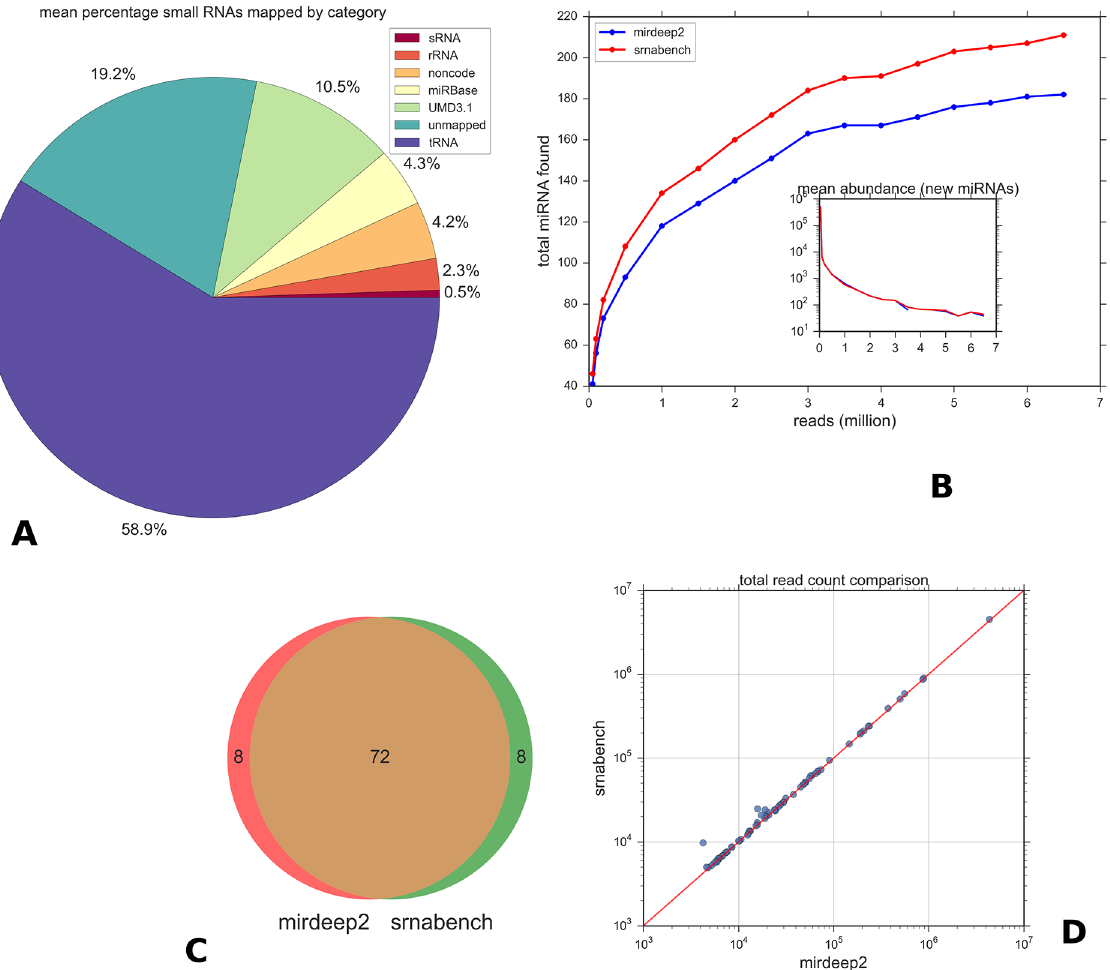
Fig 2. miRNA abundances in miRDeep2 and sRNAbench. A: Proportion of reads mapped to different small RNAs. Values are the average percentage over all samples. Reads matching tRNA dominate. The unmapped percentage is likely due to mismatches in the reads or unannotated ncRNAs. B: Variation of known miRNA discovered with increasing random reads for both methods used in this study. sRNAbench is more sensitive to low abundance genes and produces more hits at a given file size. miRDeep2 was run with no score cut-off. Discovery tails off at 4 million reads in both methods. The inset plot shows the mean abundance of each newly discovered set, illustrating that only low abundance miRNAs are being added after ~3 million mark. C: Overlap between the top 80 miRDeep and sRNAbench results for known miRNAs shows almost identical results. D: Correlation between total read counts determined by both methods for the overlapping